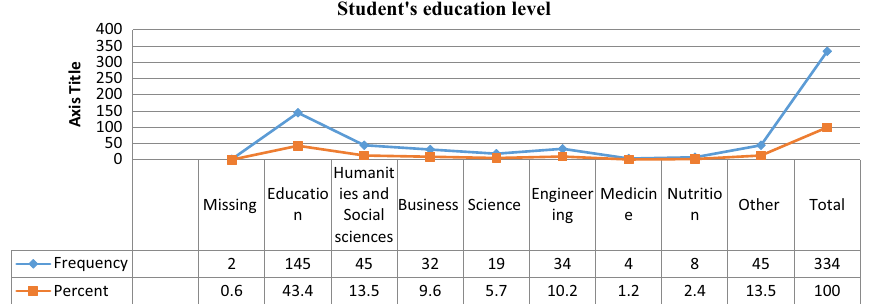
Fig. 2 Student’s education